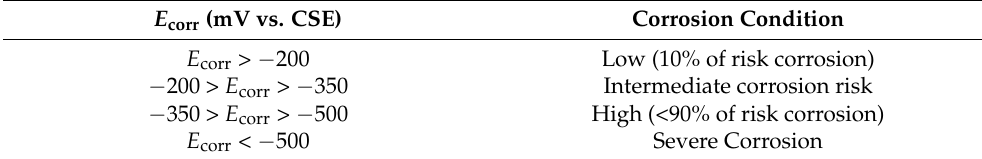
Table 8. Corrosion condition according to the measured corrosion potential ( E corr ) versus a Cu/CuSO 4 (CSE) in reinforced concrete [92].